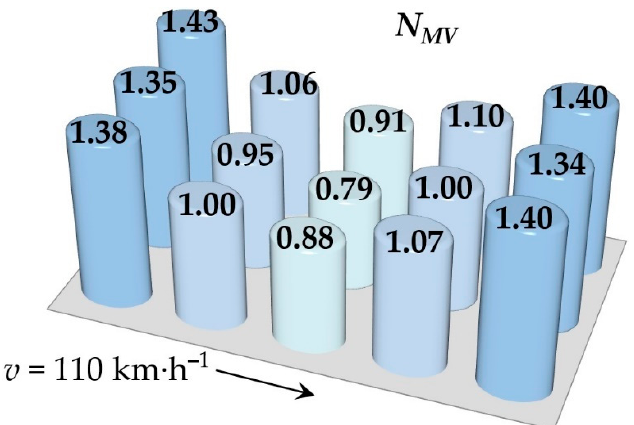
Figure 14. The distribution of the index N MV for a speed of 110 km ∙ h − 1 : the “Modification II” parameters.